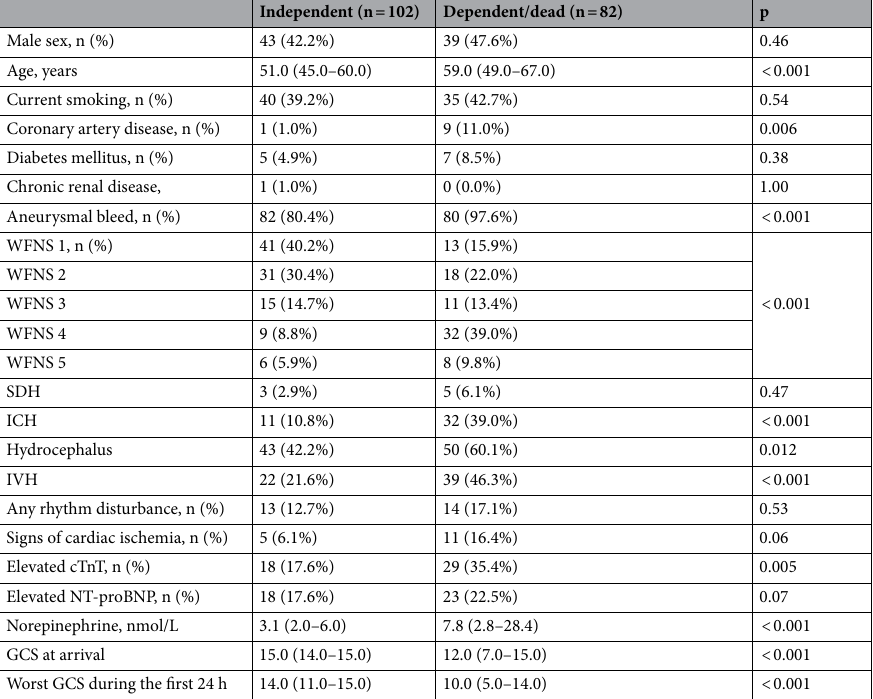
Table 8. Predictors of neurological outcome. cTnT cardiac troponin T, GCS Glasgow coma scale, ICH intracerebral hemorrhage, IVH intraventricular hemorrhage, NT-proBNP N ‐ terminal pro ‐ B ‐ type natriuretic peptide, QTc corrected QT interval, SDH subdural hemorrhage, WFNS World Federation of Neurological Surgeons.